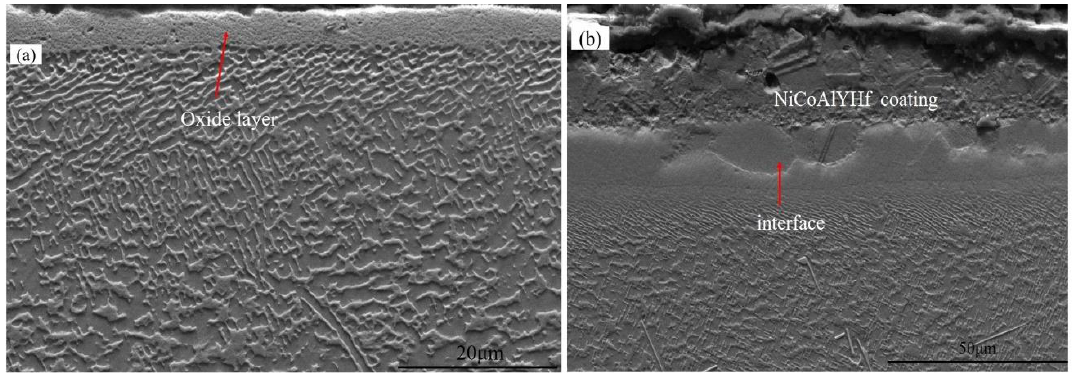
Figure 2. Specimen recrystallization morphology at 0.1 MPa sandblasting pressure in ( a ) uncoated and ( b ) coated alloys.